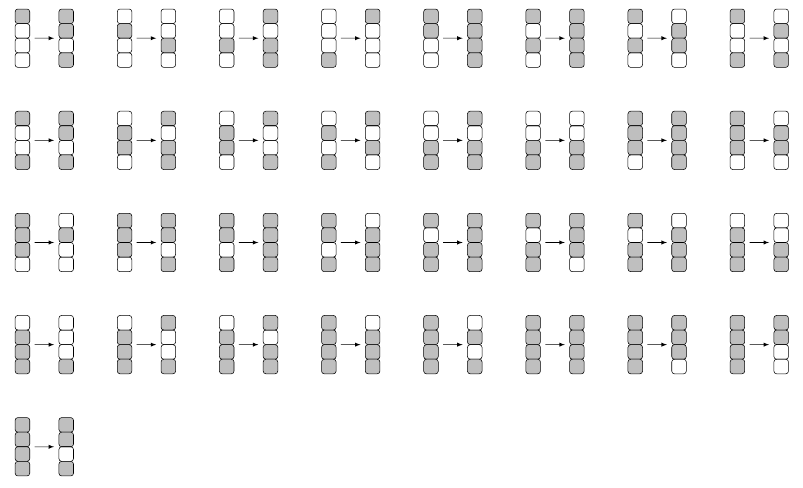
Figure 11: All possible transitions from active nibbles in a column to active nibbles after applying the Skinny MixColumns